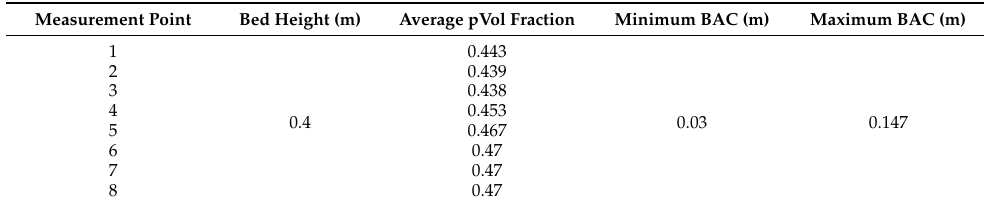
Table A1. Example of the parameters used for the simulation of bubbles at air flow conditions of 60 SCFM obtained from experimental